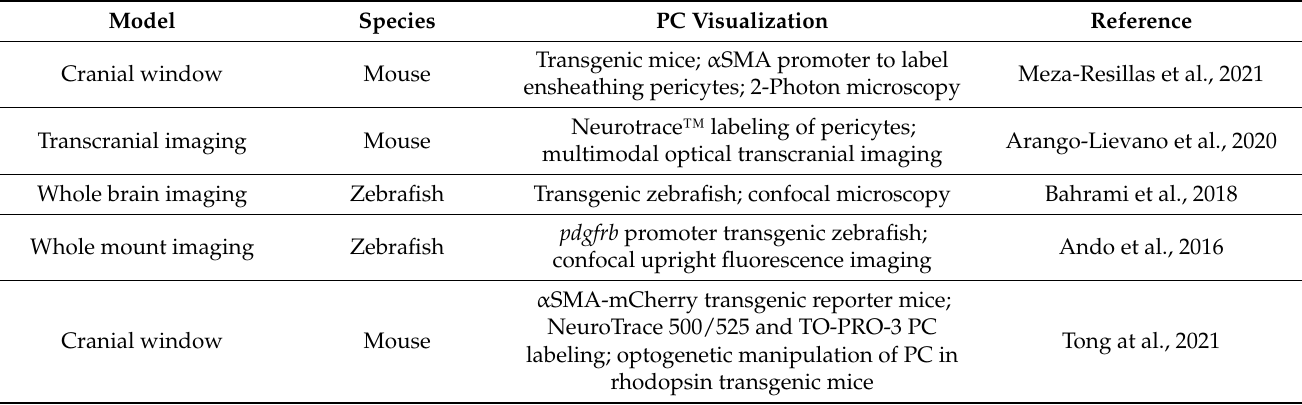
Table 2. Summary of in vivo models to study pericyte